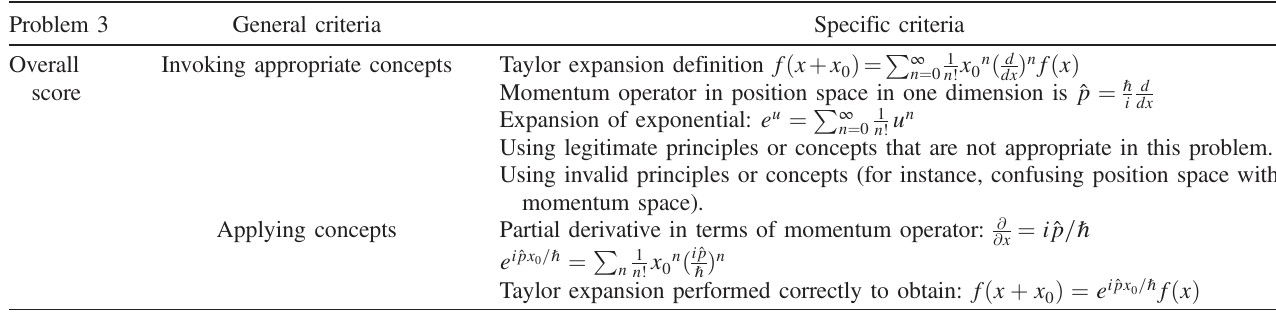
TABLE IV. Summary of the rubric used to solve problem 3 (momentum problem). In this problem, students prove that momentum operator is the generator of translation in